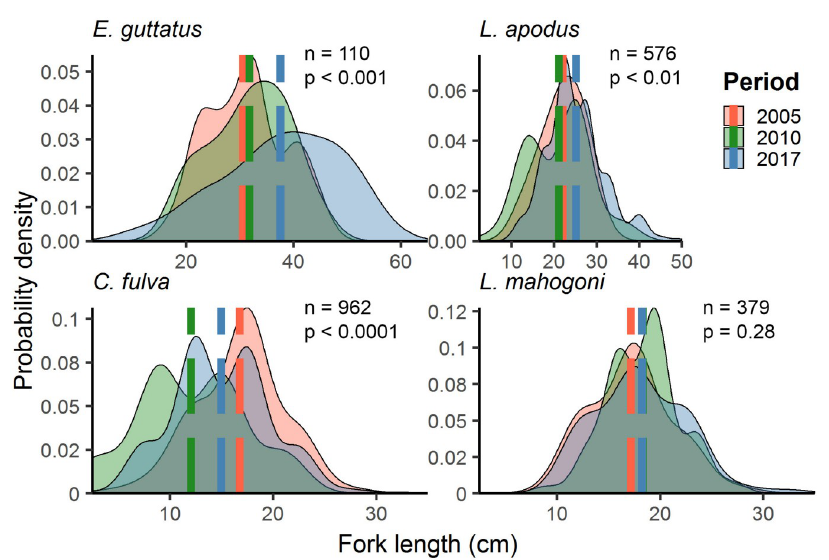
Fig 8. Probability density distributions of estimated fork length from the MNTZ. Dashed lines represent yearly means for red hind ( E . guttatus) , schoolmaster ( L . apodus ), coney ( C . fulva ), and mahogany snapper (L . mahogoni ). P values from Mann-Whitney U tests of mean rank size between 2005 and 2017.